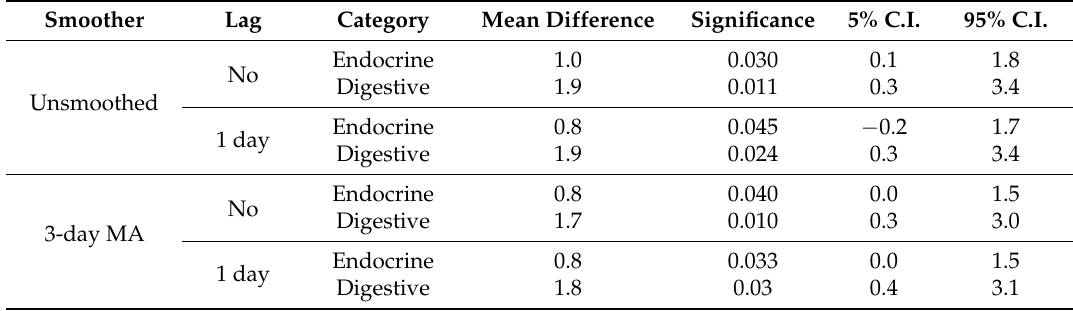
Table 7. Same as in Table 6 except the control is a one-week